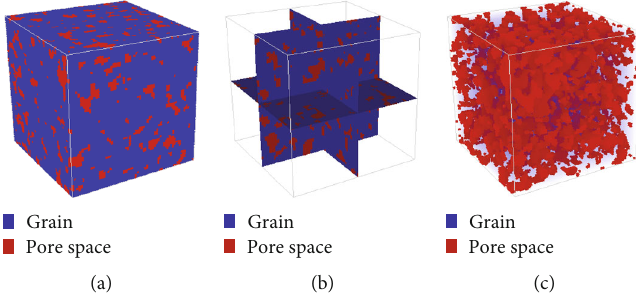
Figure 8: A reconstructed image using SNESIM: (a) exterior; (b) cross-sections ( X = 32 , Y = 32 , and Z = 32 ); (c) pore space.